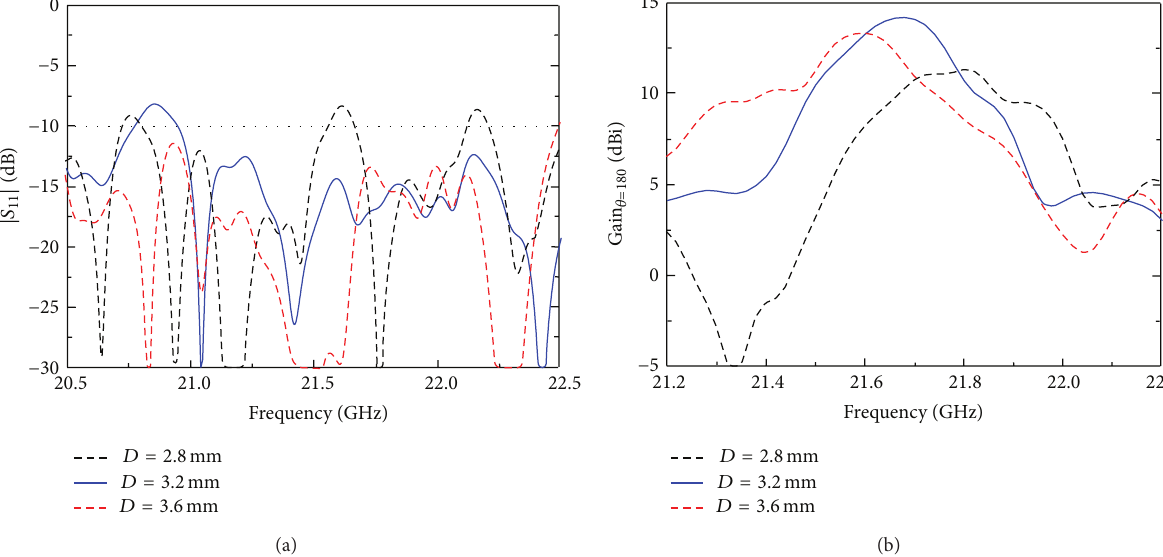
D = 2.8 mm D = 3.2 mm